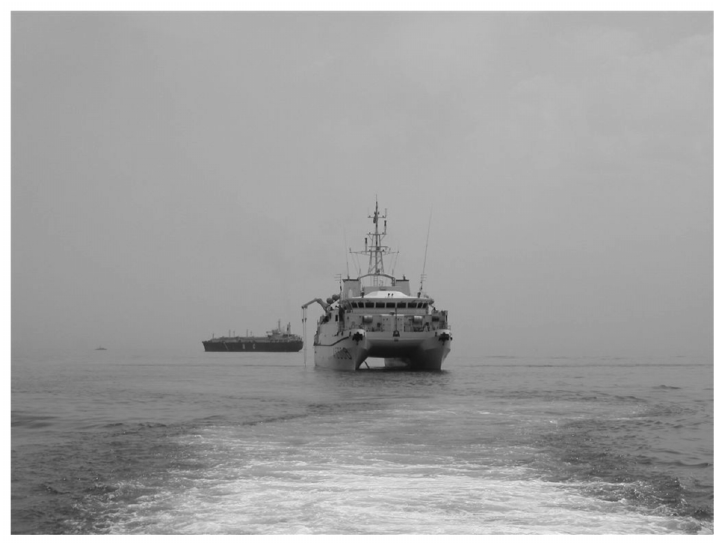
Fig. 3. Hydrographic ship Galatea.